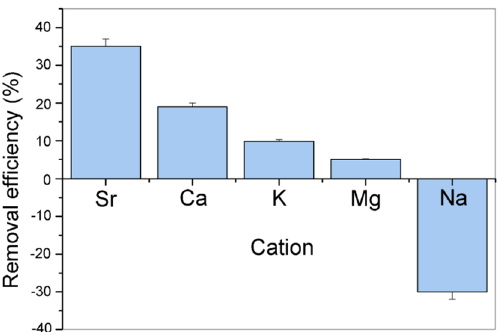
Figure 8. Competitive removal of Sr, Ca, K, Mg, and Na from the equimolar five-component mixture (0.02 mol/L of each cation) by